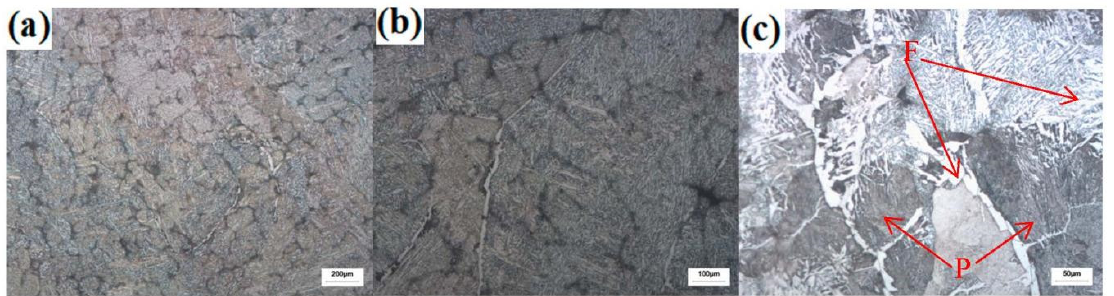
Figure 10. Microstructure of 1# as-cast tested steel (( a , b , c ) represent 50 × , 100 × and 200 × , respectively).